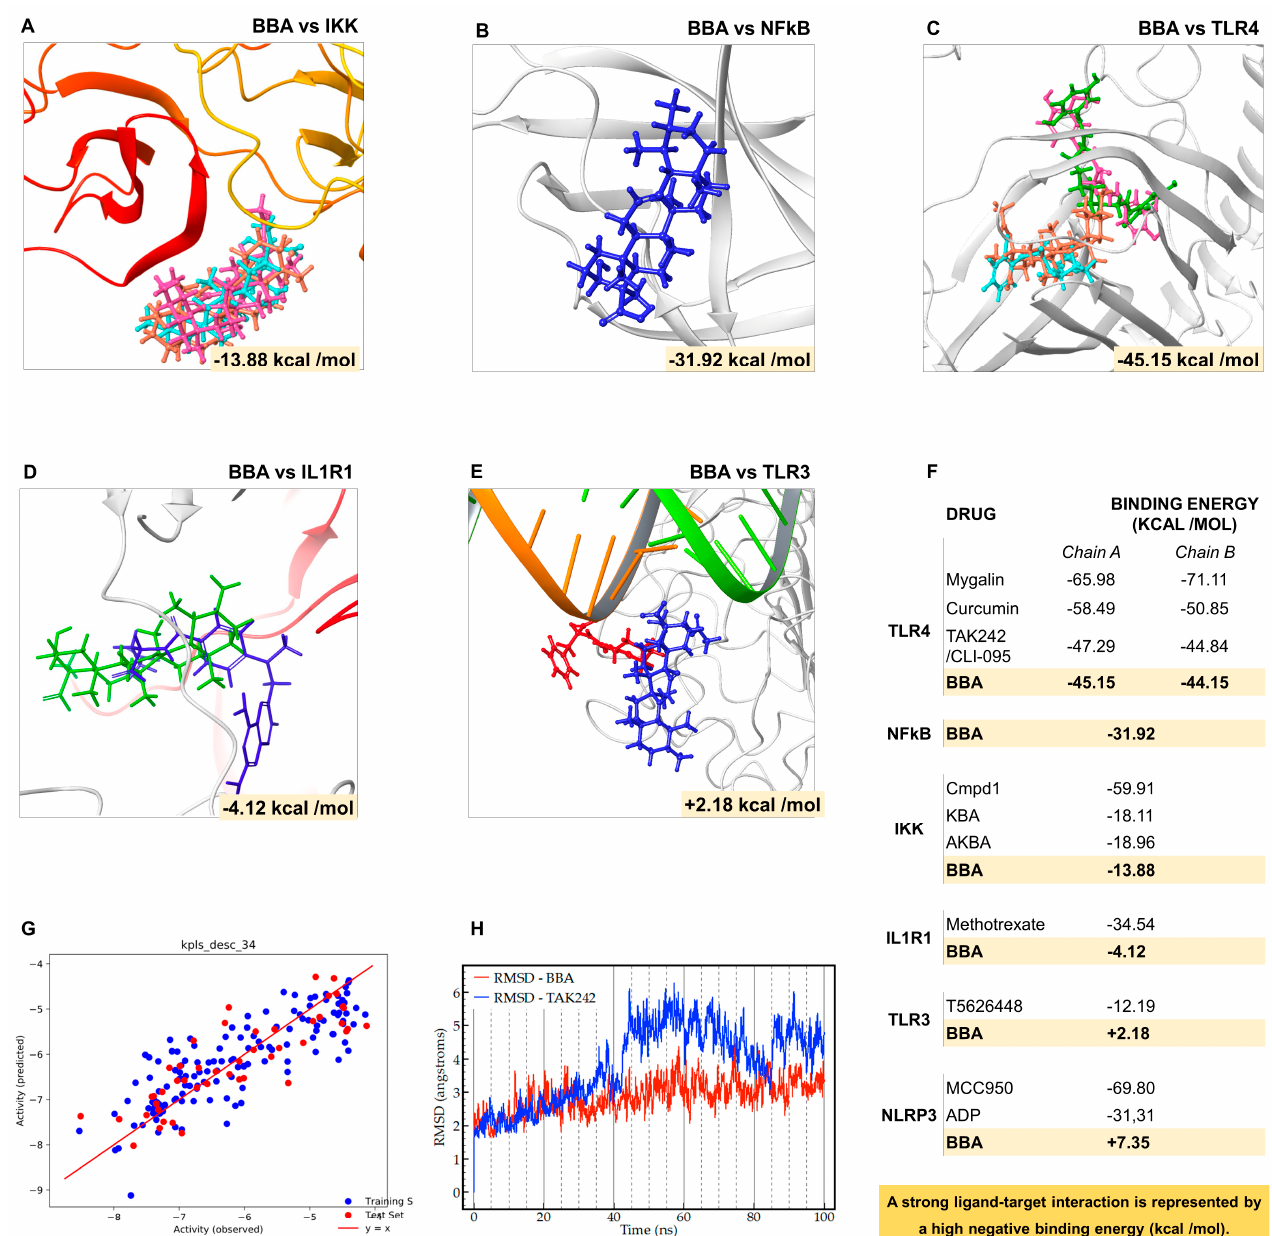
Figure 2. Predicting the binding affinity of β boswellic acid to biological targets: ( A – F ) The ability of ligands (BBA, Cmpd1, KBA, AKBA, Mygalin, Curcumin, TAK242/CLI-095, Methotrexate, T5626448, MCC950, and ADP) to dock targets ( A ) IKK, ( B ) NFkB, ( C ) TLR4, ( D ) IL1R1, ( E ) TLR3, and ( F ) NLRP3 was ranked ( F ) according to the predicted binding energy and displayed the best result (pose) in each analysis. The more negative energy, the stronger the interaction ligand-target is. The selected computational order ranks relative to the affinity; ( G ) BBA cell permeability (red dots) using a quantitative structure–activity relationships (QSAR) model trained with cell permeability data of 190 compounds (blue dots) and obtaining a log P e = 5.38; ( H ) molecular dynamics (MD) trajectories (100 ns) and root means-square deviation (RMSD) were used to measure the structural dynamic stability of a ligand docked in a target binding cite.